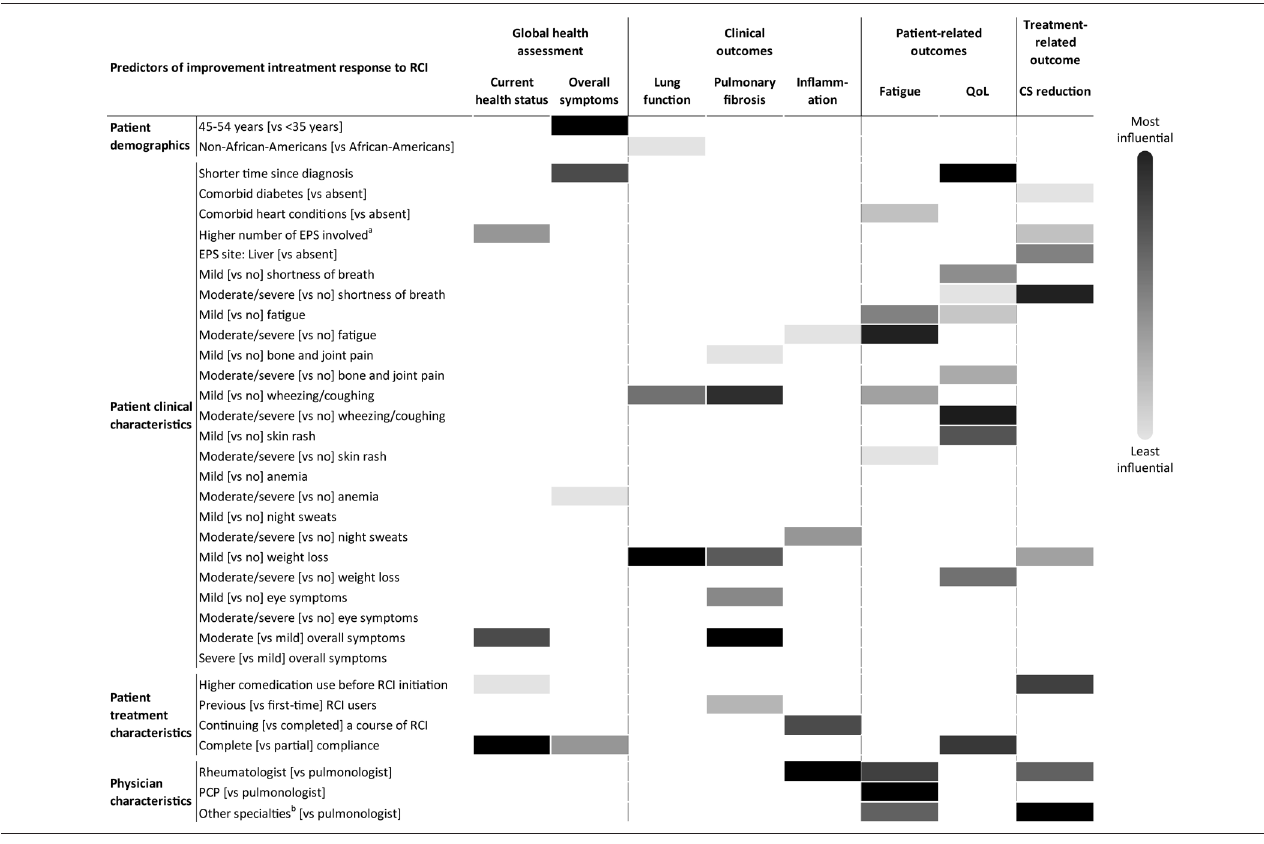
Figure 5. Summary of Predictors of Improvement in Treatment Response to